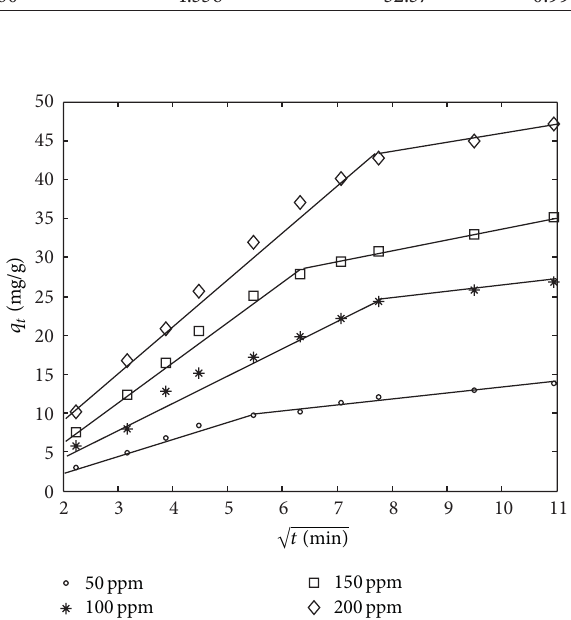
Figure 15: Intraparticle diffusion for different initial MB concentra-